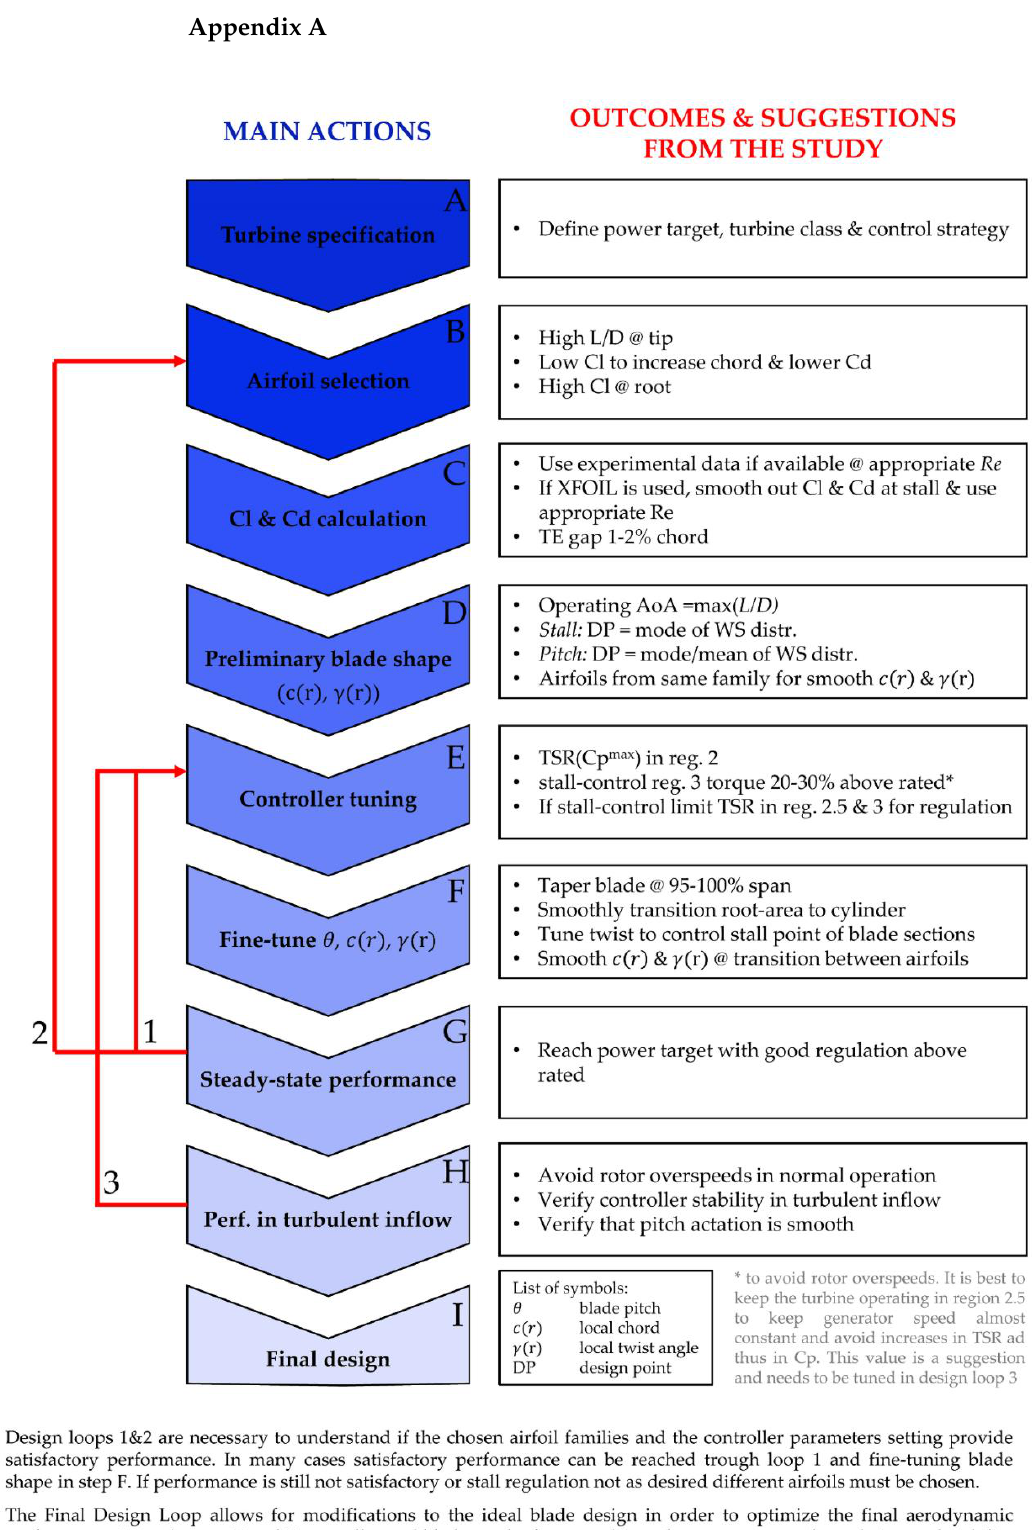
Figure A1. Conceptual scheme of the design phases for a SWT design procedure. Outcomes and suggestions from the study are reported for each phase.